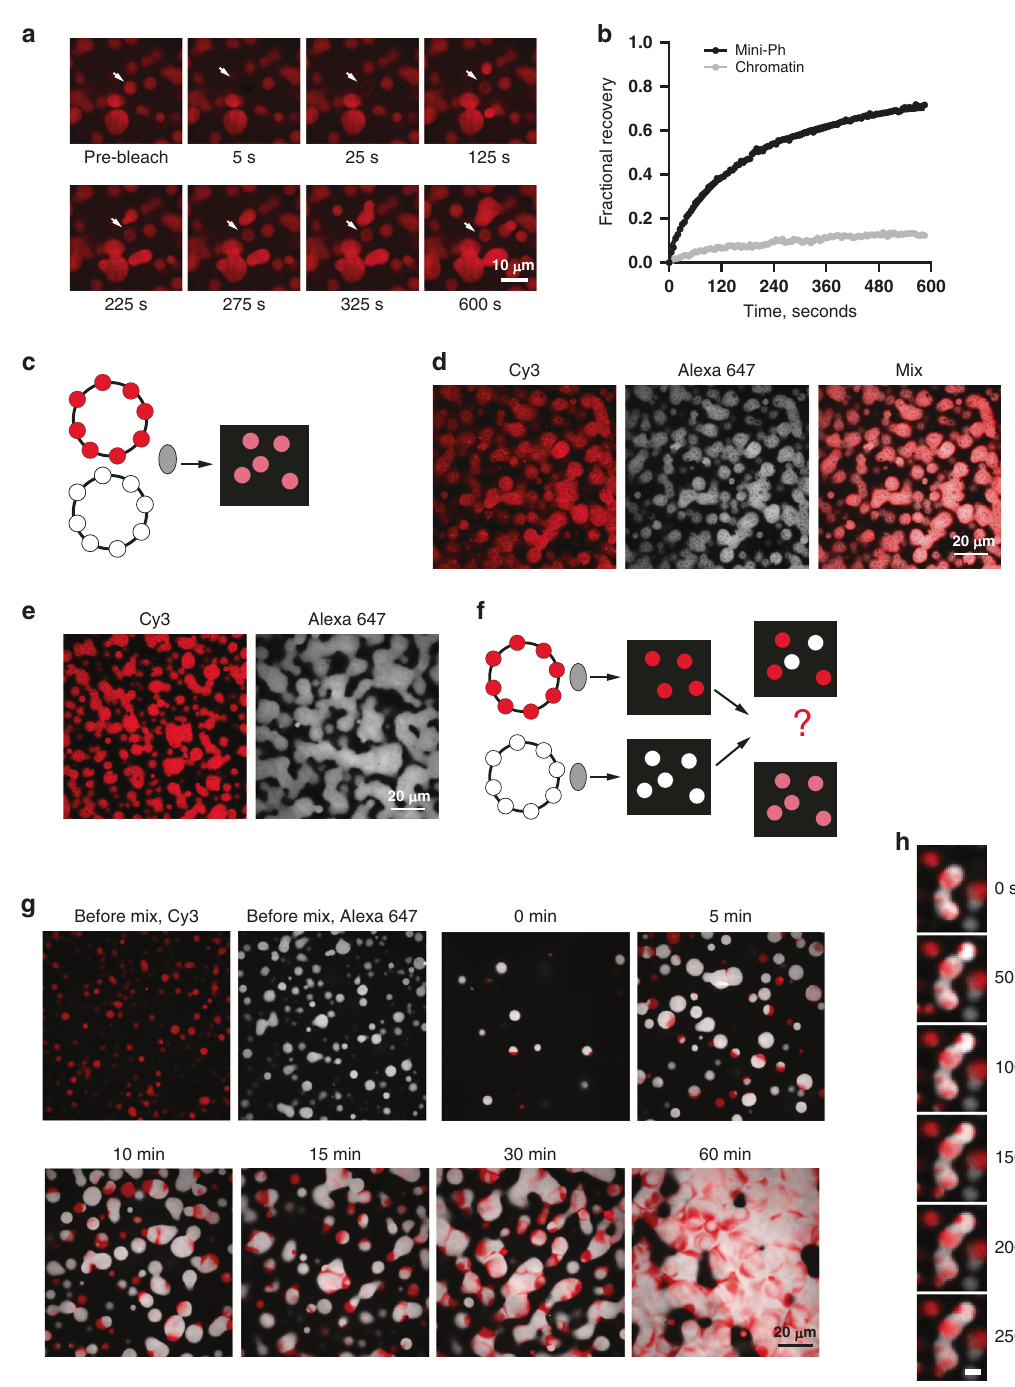
Fig. 2 Mini-Ph-chromatin condensates intermix slowly in vitro although Mini-Ph is dynamic. a FRAP experiment demonstrating that Mini-Ph-chromatin condensates exchange Mini-Ph. The structure indicated with the arrow was bleached at t = 0. b Representative FRAP traces for Mini-Ph or chromatin (after 28 or 27 min of condensate formation, respectively). Data were fi t with a double-exponential function (Eq. (1)). For Mini-Ph, % fast = 25; T1/2 Fast = 30 s; T1/2 Slow = 199 s; mobile fraction (plateau) = 0.79. For chromatin, % fast = 19; T1/2 Fast = 21 s; T1/2 Slow = 289 s; mobile fraction = 0.14. Data are representative of three independent experiments. c Scheme for mixing chromatin labeled with different colors before adding Mini-Ph. d Mini-Ph-chromatin condensates formed with an equal mix of Cy3 and Alexa-647-labeled chromatin. e Mini-Ph-chromatin condensates formed with either Cy3 or Alexa-647- labeled chromatin. f Scheme for mixing Mini-Ph-chromatin condensates formed with differently labeled chromatins. g Mini-Ph-chromatin condensates were formed with Cy3- or Alexa-647-labeled chromatin and mixed together. The images shown are representative of three independent experiments. h Time lapse of fusion of condensates in the mixing experiment. See also Supplementary Fig.